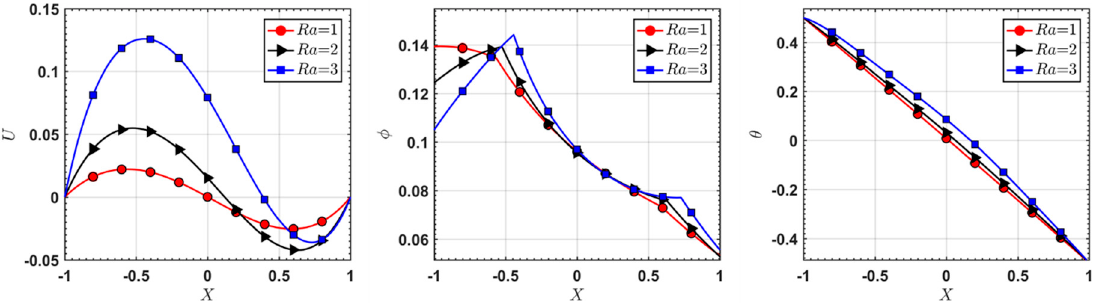
Figure 9. Effect of buoyancy force term, Rayleigh number ( 𝑅𝑎 ) on the velocity, concentration and temperature profiles, when 𝛤 𝑐 = 1.0 , 𝛤 𝜇 = 0.1 , 𝛤 𝑔 = 1 , 𝛽 = 10° , 𝐿𝑒 = 10 , 𝑛 = −0.5 , 𝛿 = 1 , 𝐵𝑟 = 5 and 𝜙 𝑎𝑣𝑔 = 0.1 .